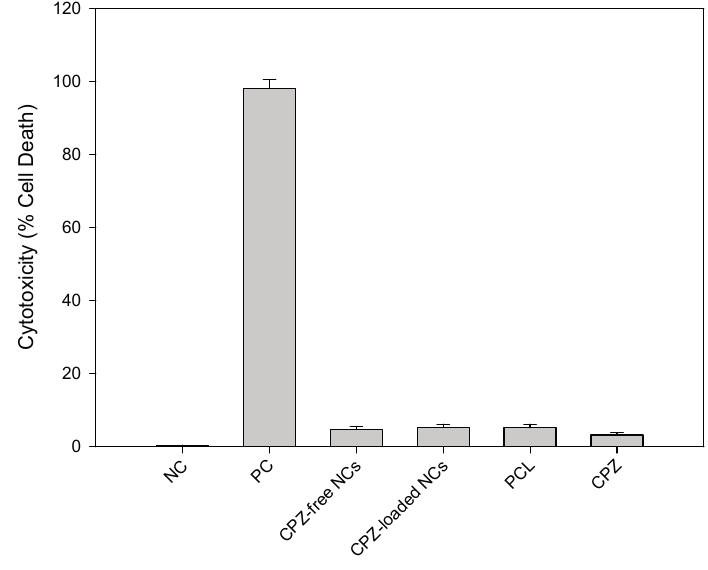
Figure 16. Cytotoxic evaluation of PC12 neuronal cells upon exposure to the nanocapsules utilizing the CytoTox96 ® Non-Radioactive Cytotoxicity